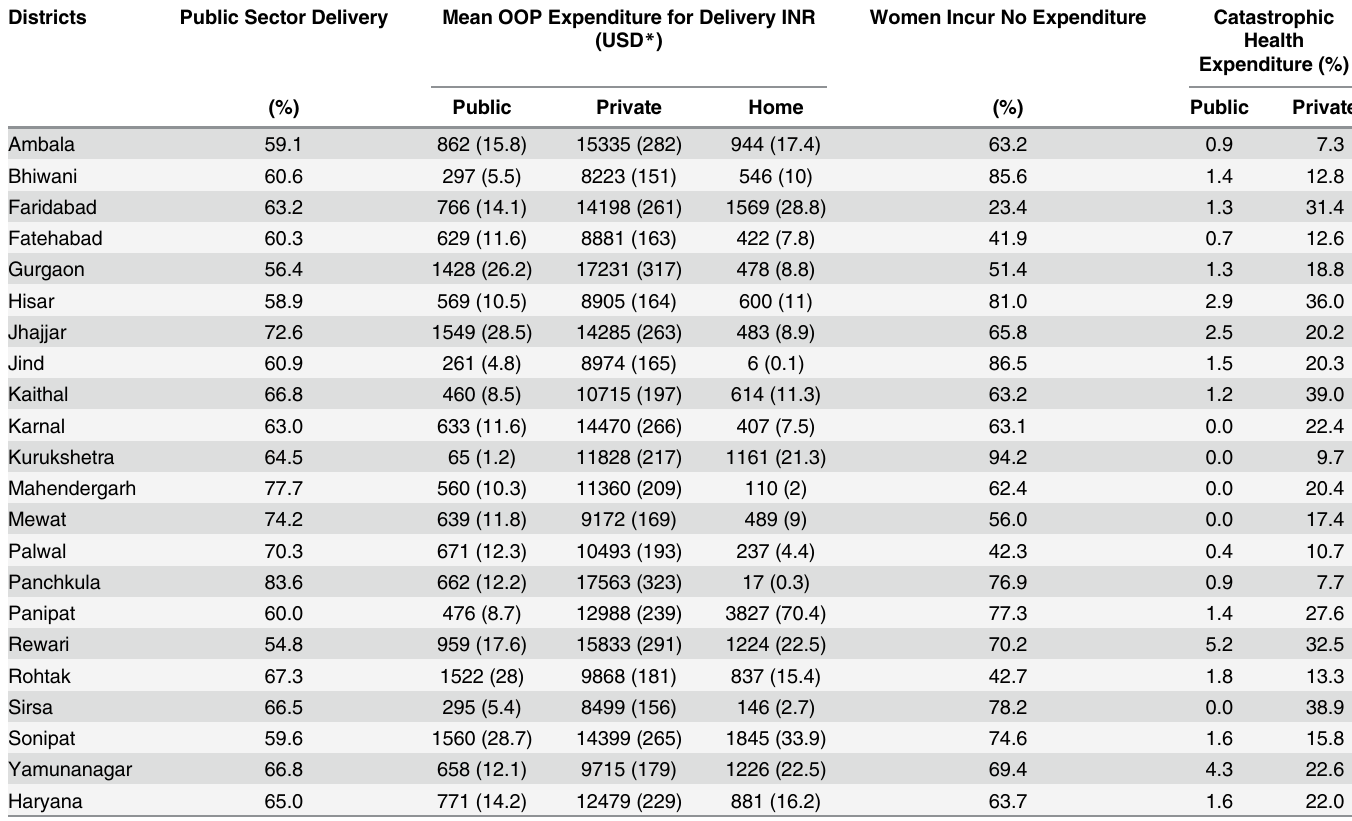
Table 3. Care Utilization and Out-of-Pocket Expenditure for Delivery in 21 Districts of Haryana State, India.